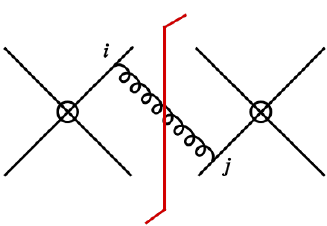
Figure 2 . Feynman diagram for the NLO soft function. The solid lines pointing towards the cut represent the Wilson lines of the top quarks. The lines pointing away from the cut correspond to the Wilson lines of the incoming, massless partons, quarks or gluons. The diagram represents a class of graphs with all possible gluon connections between the Wilson